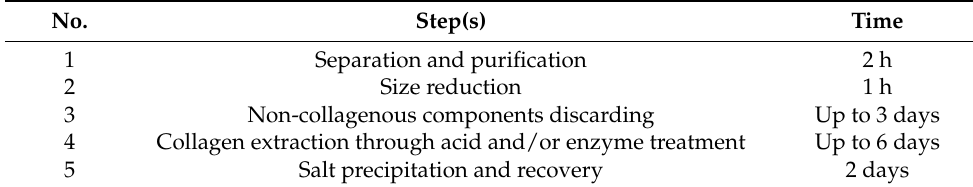
Table 1. Five steps of collagen extraction process from fish sources [88–90].